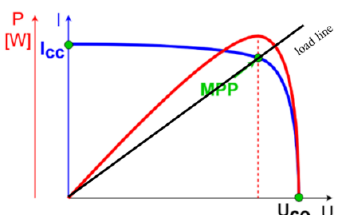
Figure 10: Characteristics I (V) and P(V) of a PV module . The algorithm of INC_C exploit the slope of the P (V) curve to detect the MPP. If the algorithm finds that the operating point is at the top of the curve P (V), corresponding to a slope is zero, and equation (6) is satisfied, then the duty cycle α of the DC-DC converter is fixed and no oscillation occurs during this step until changes in the slope occur. In real life, the zero slope condition is rarely reached.